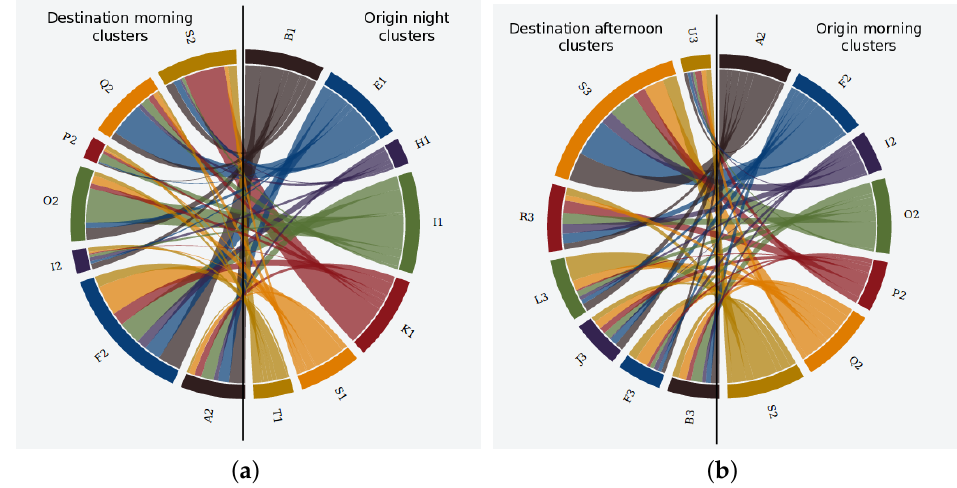
Figure 10. Mobility patterns for MD dataset. ( a ) transition from night to morning clusters; ( b ) transition from morning to afternoon clusters.